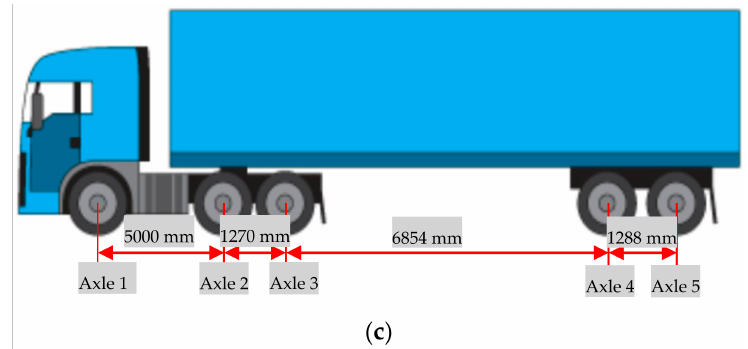
Figure 1. Illustration of axle configurations (schematic indication) for ( a ) Class 5; ( b ) Class 7; and ( c ) Class 9 trucks